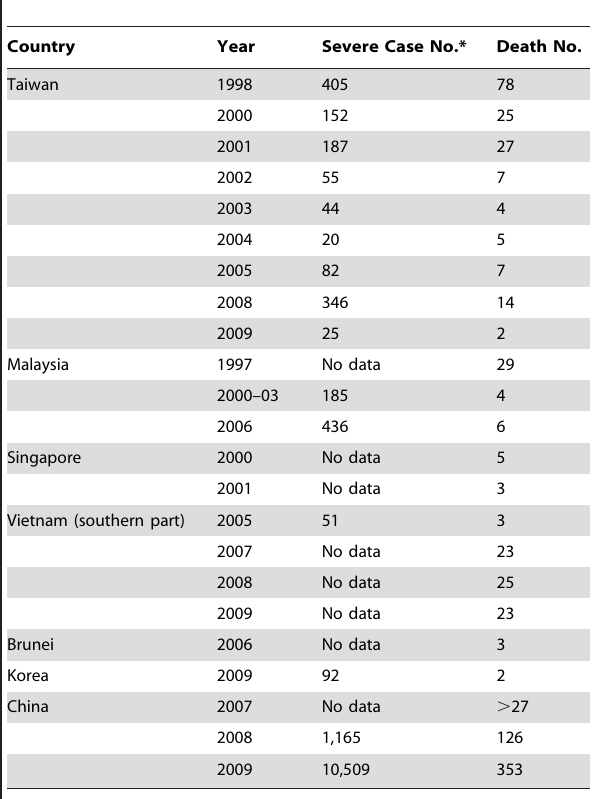
Table 5. EV71-related severe and fatal cases in Asia, 1997– 2009.